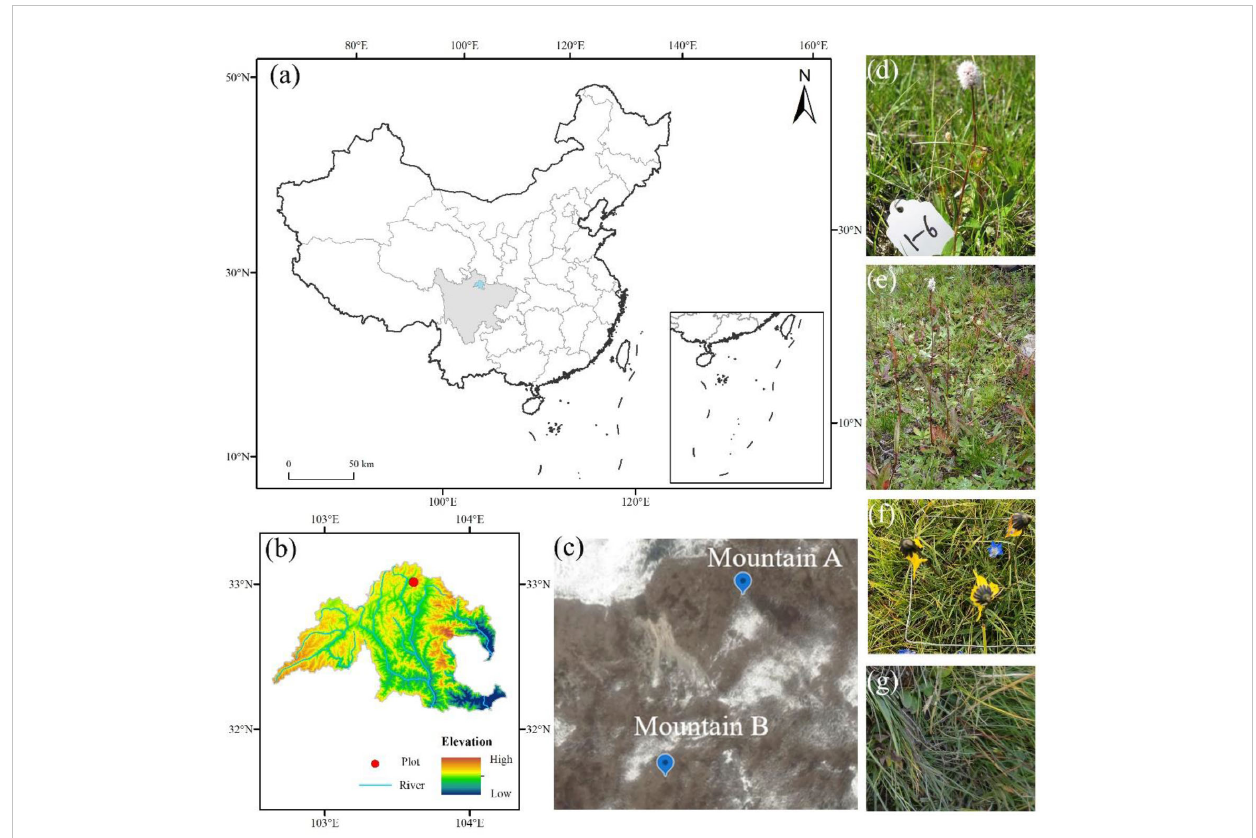
FIGURE 1 Study site (C) at mountain Kaka and its location at Songpan county (B) and China (A) . Four target species are selected in this study, including Bistorta macrophylla (D) , Bistorta vivipara (E) , Cremanthodium discoideum (F) , and Deschampsia littoralis (G)